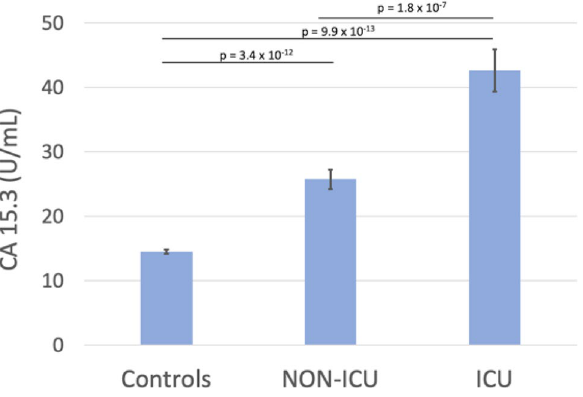
Figure 3. CA 15.3 serum levels in SARS-CoV-2 infected patients, divided according to their hospitalisation in Intensive Care Unit (ICU) or other in different wards (NON-ICU), and control